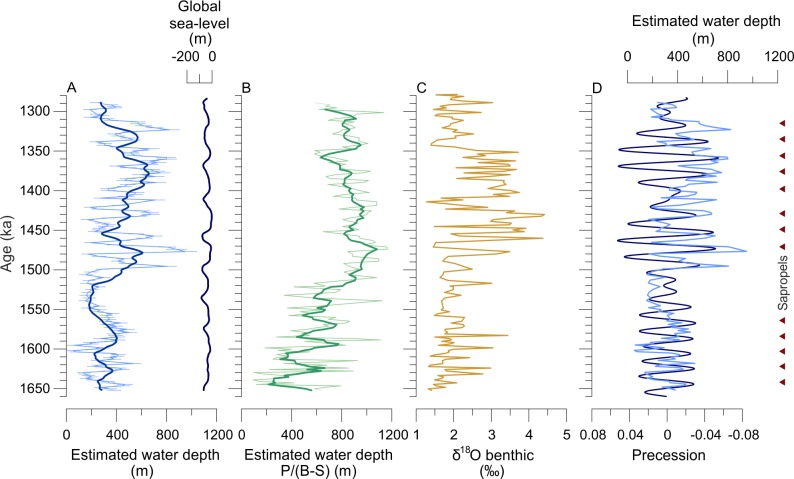
Paleo-water depth reconstructions for the Pefka E section.A. Original paleo-water depth reconstructions (excluding those samples with extremely poor fit to water depth) as thin line with sample specific error (error bars) and moving average of paleo-water depths with window size matching average precession period. For reference, global ice volume transferred into global sea level in meter relative to present [125] is given. B. Paleo-water depth estimates based on planktic/(benthic−stress markers) (P/(B−S)) ratios using the transfer function from Van der Zwaan et al. [123], with the thin green line showing the original reconstruction and the thick green line showing a five point moving average. C. Benthic foraminifera stable oxygen isotope ratios (δ18O). D. Comparison of the original paleo-water depth reconstructions (light blue) versus precession (dark blue) [73]; note inverse scaling of the precession curve. Symbols show Pleistocene sapropels identified in ODP Site 967 and ODP Hole 969D (Eastern Mediterranean Sea) [72].